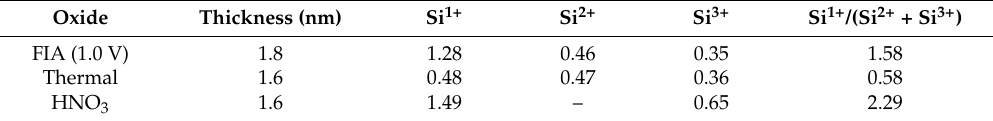
Table 1. Oxide thickness (determined from ellipsometry using a refractive index for thermal oxide of 1.46) for the SiO x layer grown using different methods and the atomic percentage of the Si 1+ , Si 2+ and Si 3+ peaks obtained from XPS with the calculated sub-oxide ratio Si 1+ /(Si 2+ + Si 3+